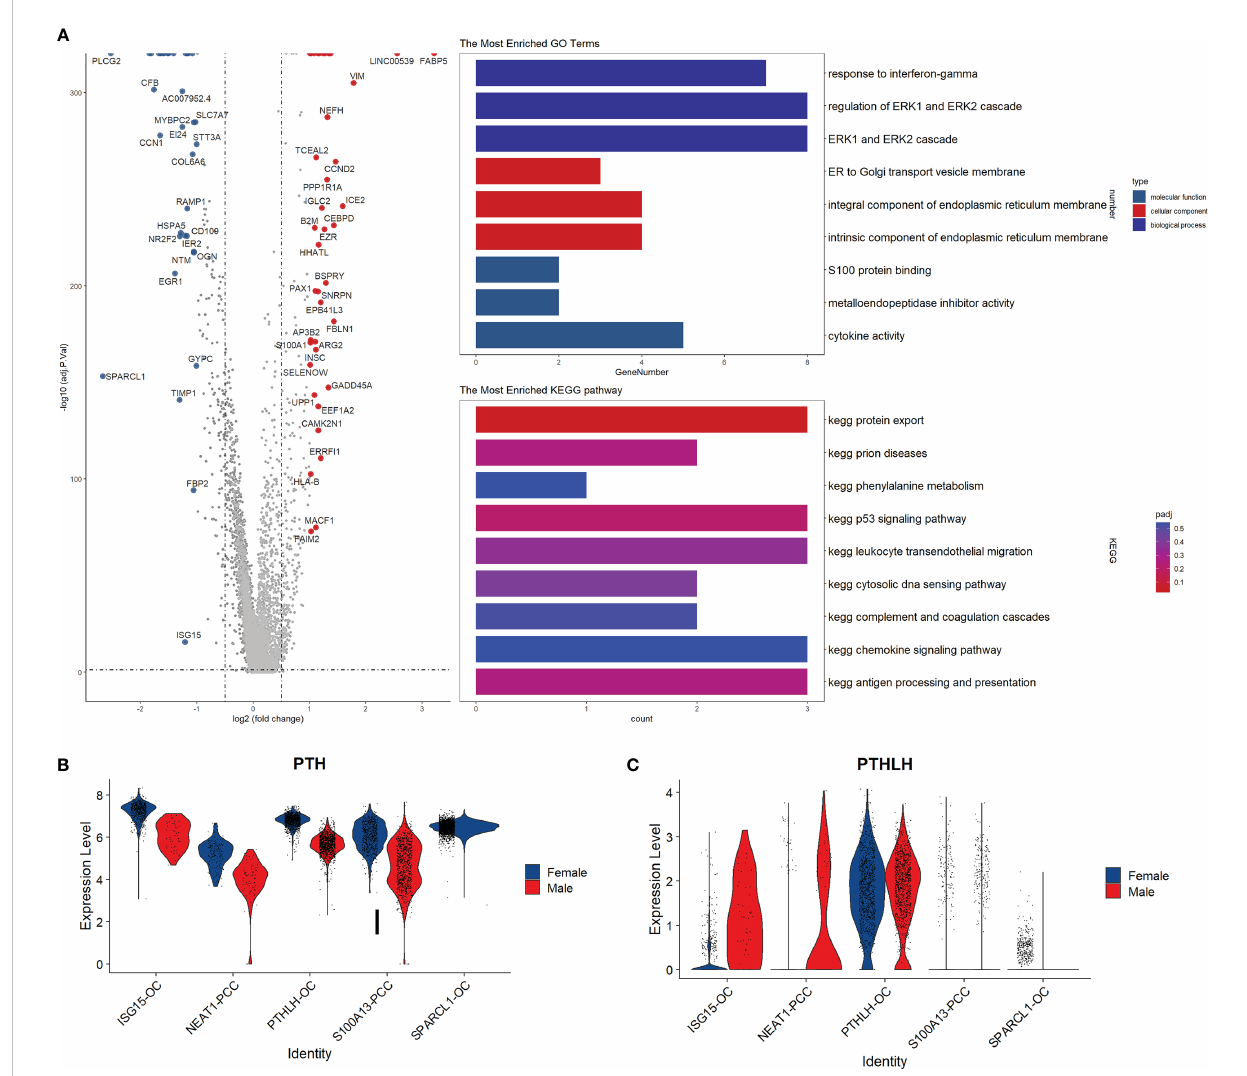
FIGURE 5 Subpopulation analysis of parathyroid cells. (A) Volcano plot and functional enrichment analysis of the differential expressed genes between female and male patients. Red points represent the signi fi cantly up-regulated genes in males compared with females (adjust-p<0.01, logFC>1). Blue points represented the signi fi cantly down-regulated genes in males compared with females (adjust-p<0.01, logFC<-1). (B, C) Expression levels of PTH and PTHLH in different cell